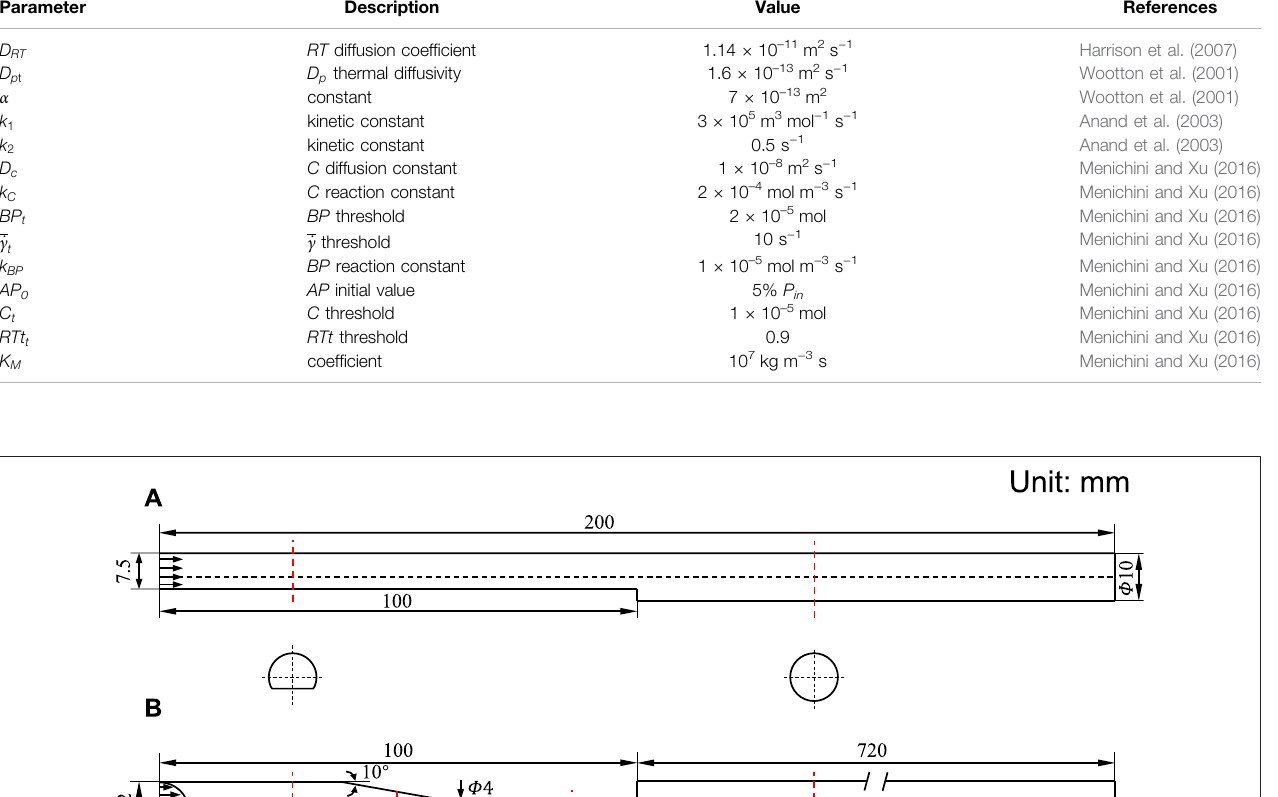
Frontiers in Physiology |